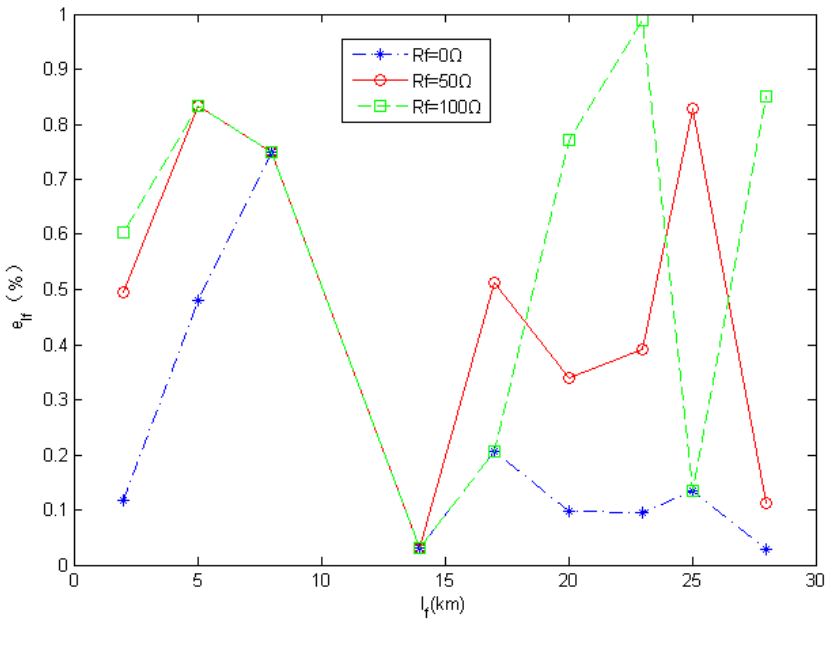
Figure 7. The influence of R